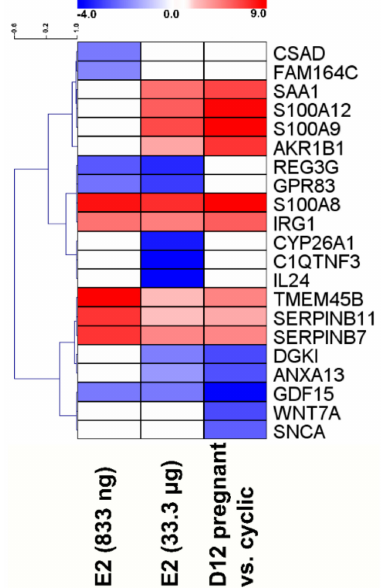
Figure 1. Heatmap of the log2 fold changes (estradiol-17 β (E2)-treated endometrium vs. placebo-treated endometrium; day12pregnant-cyclic)ofthetop10di ff erentiallyexpressedgenesofeachgeneexpression comparison. The scale is from log2 fold change -4 (blue, down-regulated in E2-treated / pregnant samples) to 9 (red, up-regulated in E2-treated / pregnant samples). Each row represents one gene, and each column represents a comparison (E2-treated vs placebo or pregnant vs.